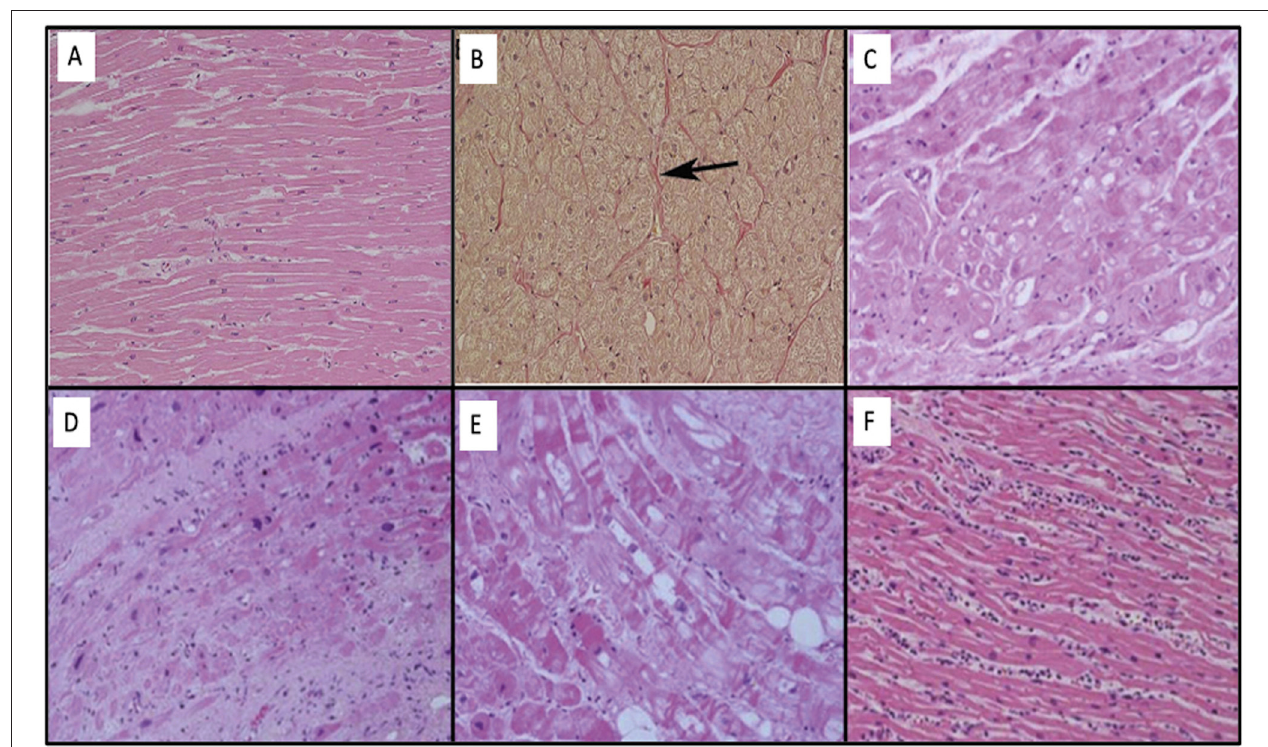
FIGURE 2 | (A) Normal histology of the left atrium with the presence of extensive bands of homogeneous myocytes. (B) Even the atrium in Panel (A) with Van Gieson stain demonstrates that collagen fibers (red color) are identified in the adventitious space of blood vessels (arrow). (C) EHRAs Class I: modifications mainly associated with the myocyte through hypertrophy and myocytolysis. (D) EHRAs Class II: modifications mainly associated with fibrotic changes. (E) EHRAs Class III: mixture of changes in myocyte changes and fibrosis. (F) EHRAs Class IV: neutrophilic